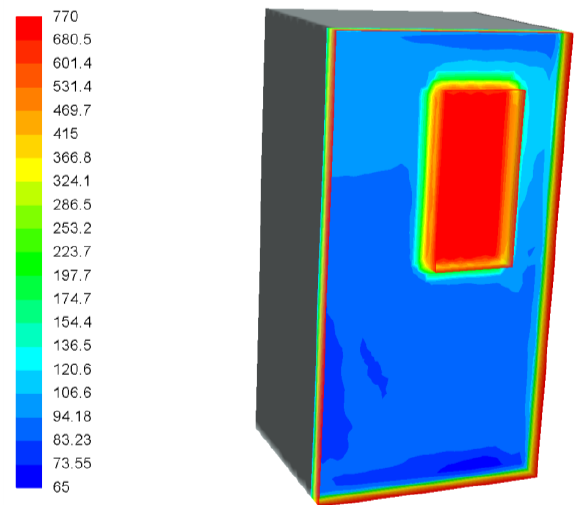
Figure 6. Temperature profile on the box surface